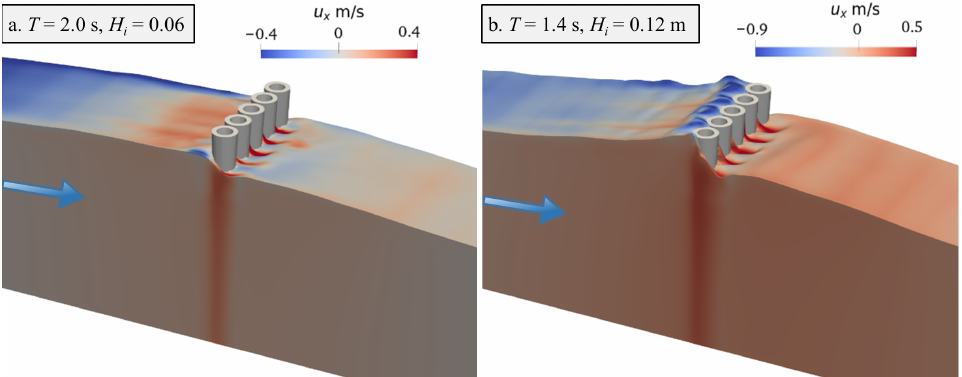
Figure 16. Wave interaction with the CPHB structure ( D/H max = 0.4) for gentler and steeper